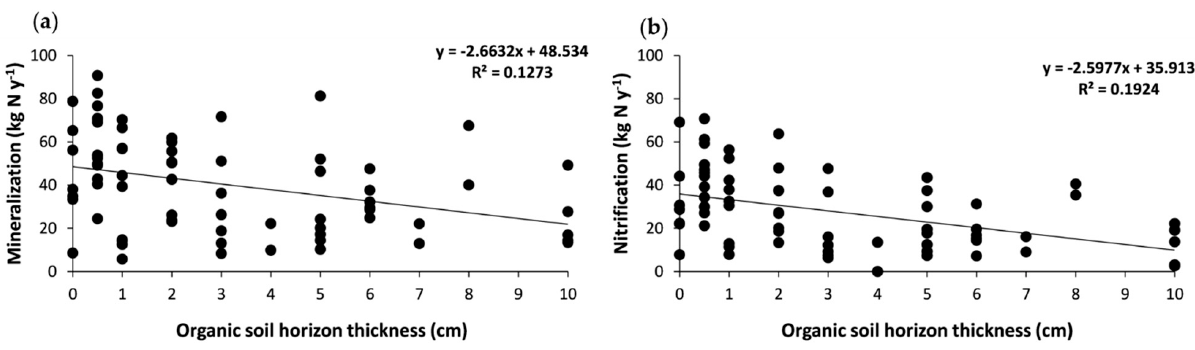
Figure 6. Effect of the organic soil horizon thickness on net annual N mineralization ( a ) and net annual nitrification ( b ).